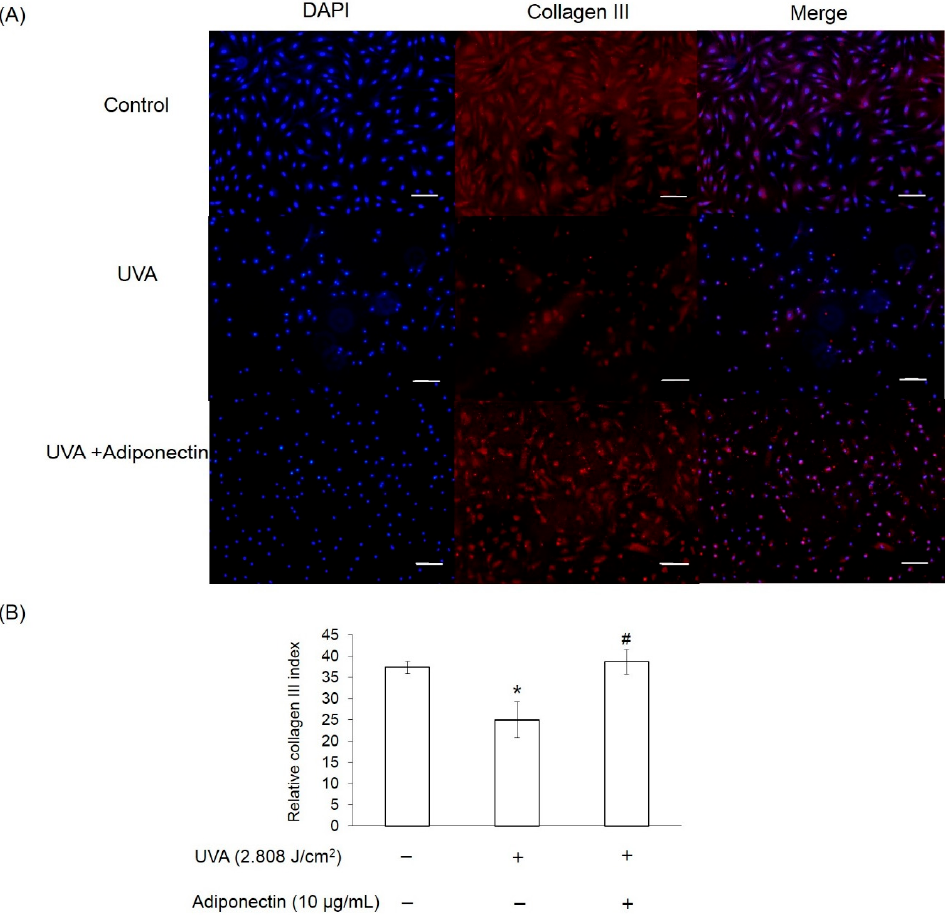
Figure 9. The effect of adiponectin on type III collagen expression in UVA-irradiated Hs68 fibroblasts. ( A ) Immunofluorescence staining of Hs68 fibroblasts using specific type III collagen antibody (×100 magnification, Scale bar = 200 μ m); and ( B ) quantification of immunofluorescence staining of Hs68 fibroblasts. Red fluorescence staining indicates the presence of type III collagen. Blue staining illustrates the DAPI nuclei counterstain. * p < 0.05 with respect to control; # p < 0.05 with respect to UVA.